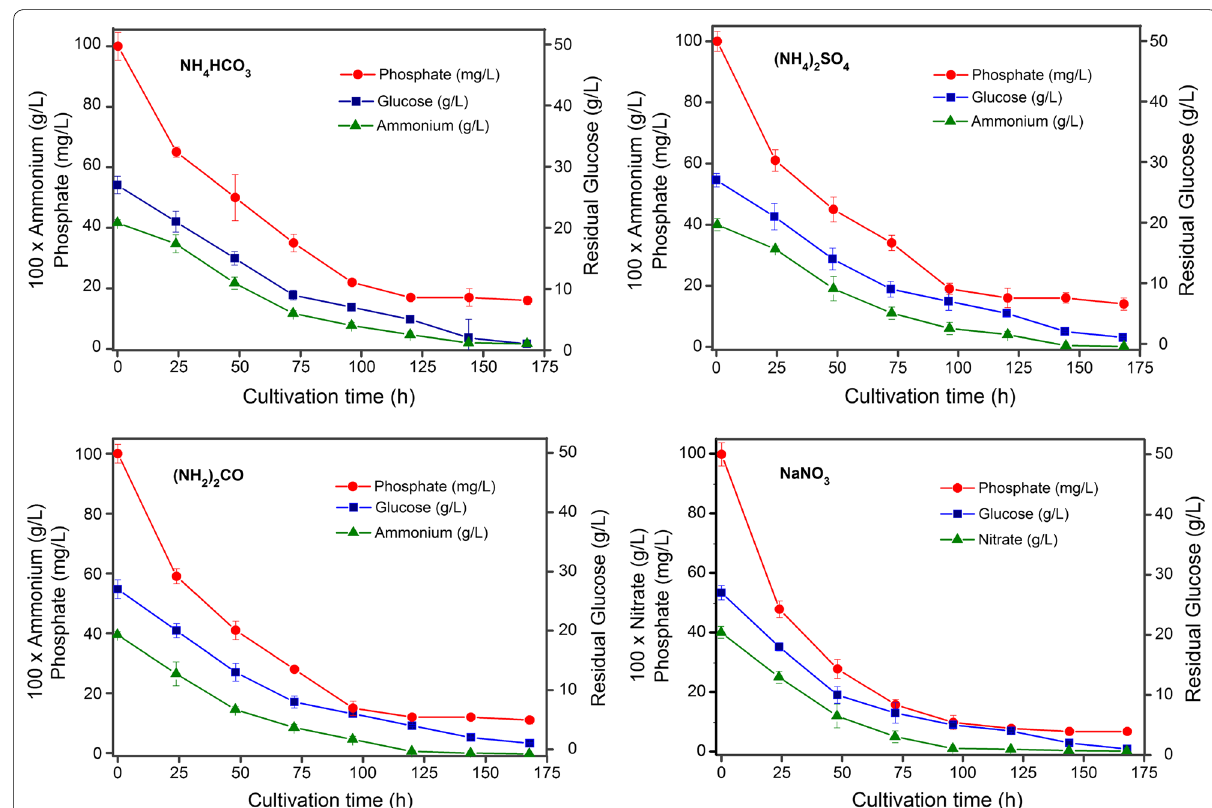
Fig. 2 The time-course profile of residual substrates (glucose, nitrate and phosphorus) concentration in C. cohnii cultured on different nitrogen sources for 7 days. All experiments were performed in triplicate. The data presented here is